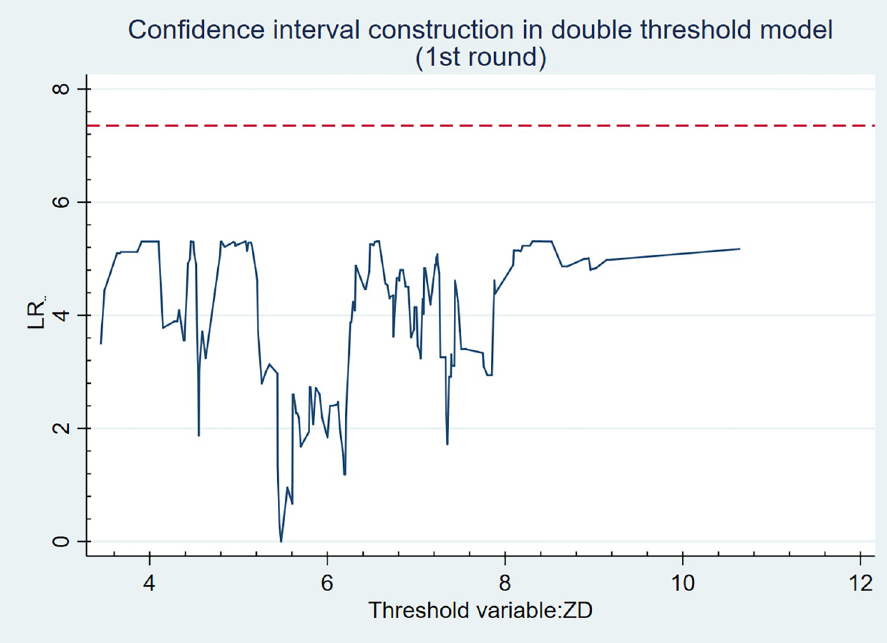
Fig 2. The likelihood ratio function diagram of the second threshold value.